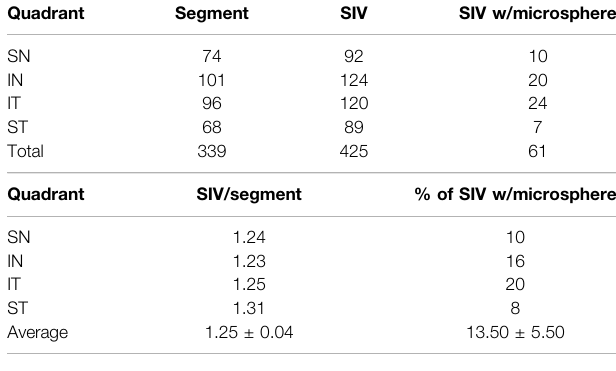
TABLE 2 | Per quadrant analysis (only quadrants with all four segments examined were included in this analysis. Additional segments were imaged in the study but not included in the quadrant breakdown) SC inlet valve-like structures (SIV).